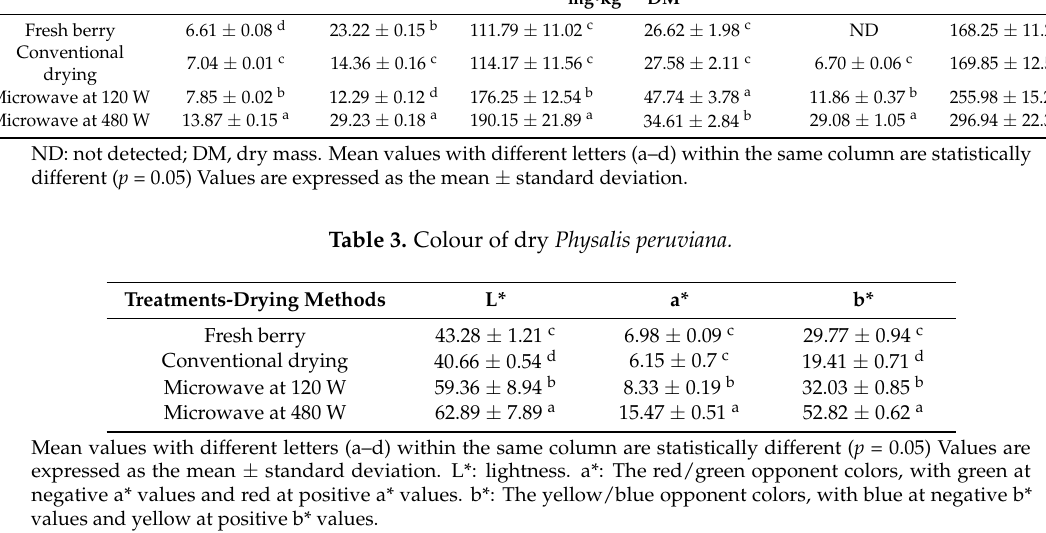
Table 2. Content of carotenoids in fruit of Physalis peruviana with different methods of drying. Treatments-Drying Methods